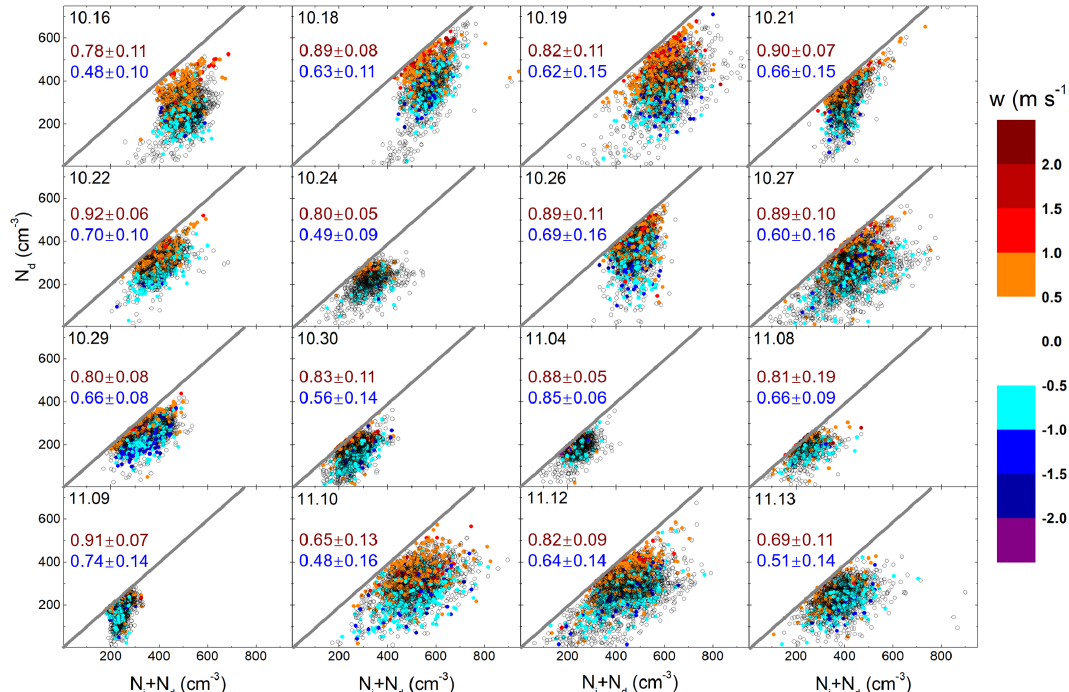
Figure 6. Relationships between N d and N i + N d during all 16 non-drizzling flights. The color represents in-cloud vertical velocities (ms − 1 ), and gray line is 1 : 1 line. The mean and standard deviation of N d /(N d + N i ) for vertical velocity greater than 1ms − 1 (red) and less than − 1ms − 1 (blue) are